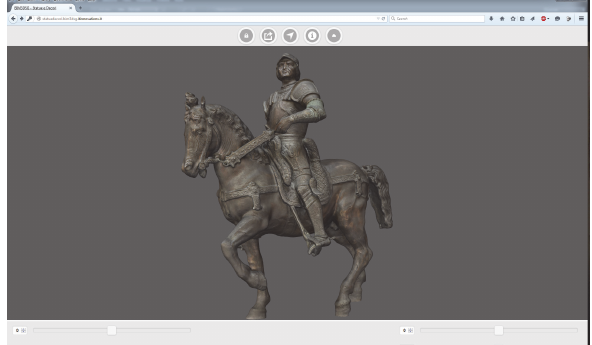
Figure 11. The statue inside BIM3DSG, the view is centre on the object and the sliders below permit the standard actions of zoom and rotation. The user friendly icons in the upper part let to see info and